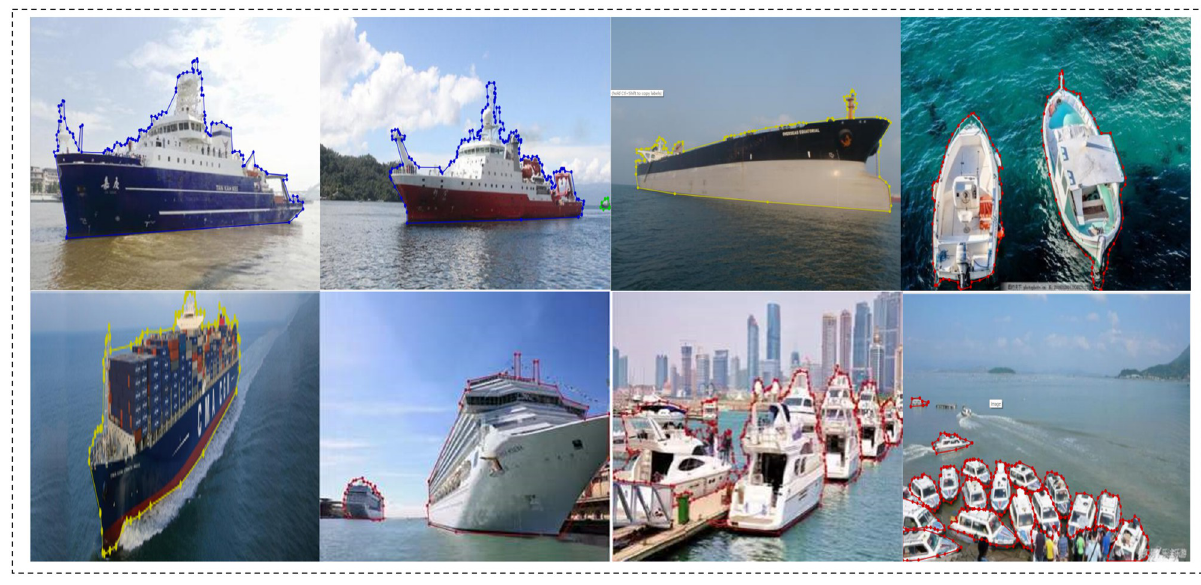
Fig 3. Representative images from MariBoats with manual annotations. The manual delineations are indicated in blue, yellow or red.